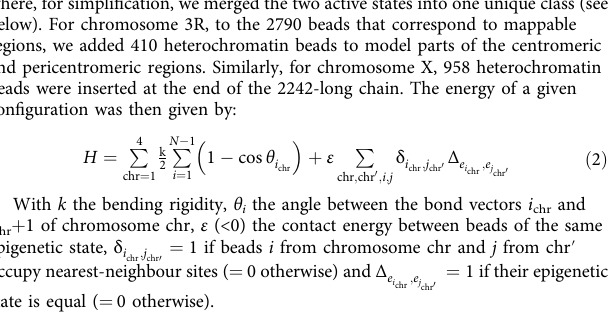
described in Ghosh and Jost 40 . Each chromosome consisted of N = 3200 beads of 10kb, each of size b . The four polymers moved within a cubic box of size L x × L y ×